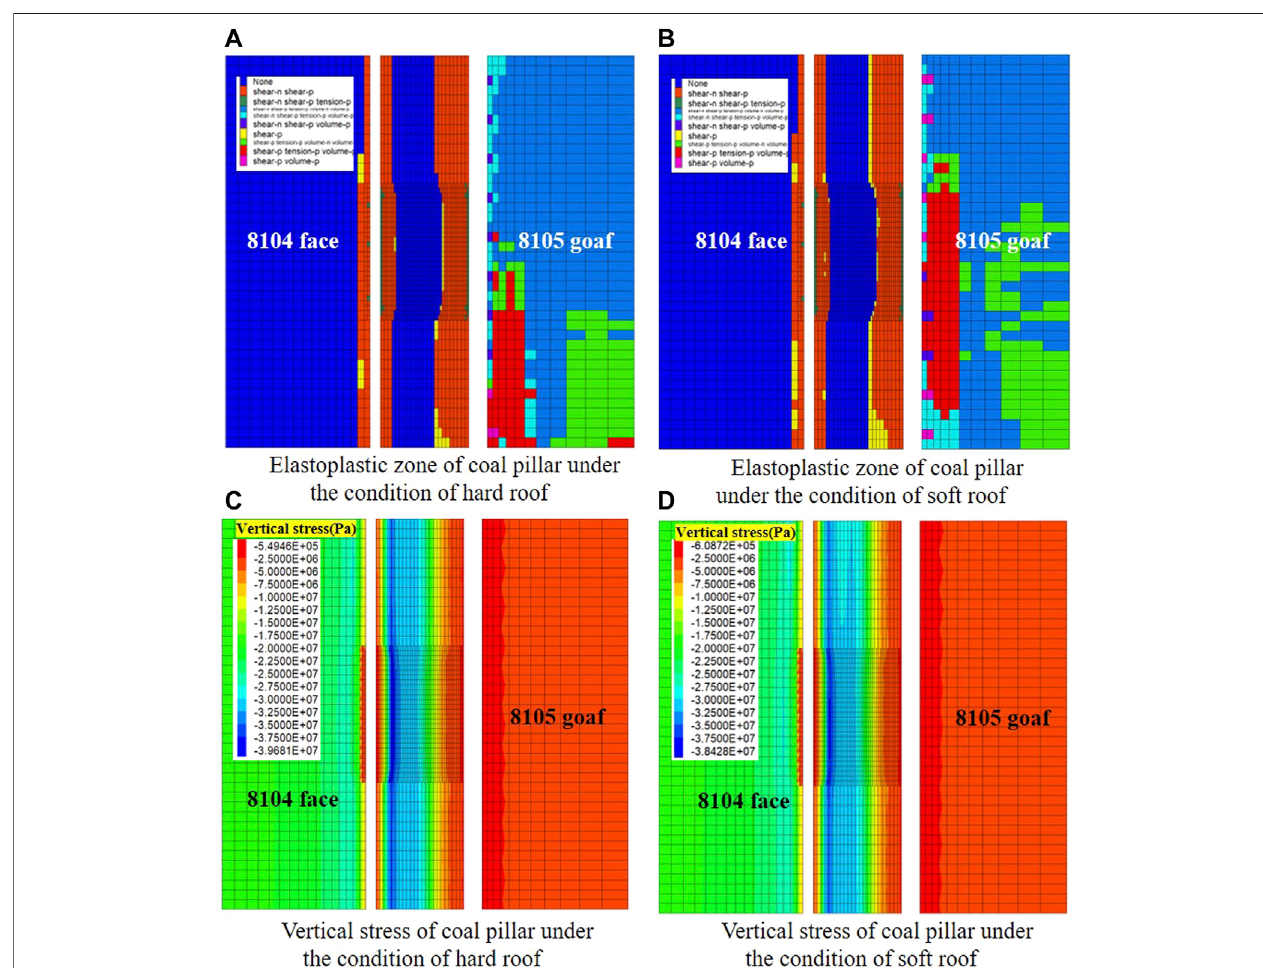
FIGURE 7 | Coal pillar stress and damage after fi rst mining under different roof strength conditions.